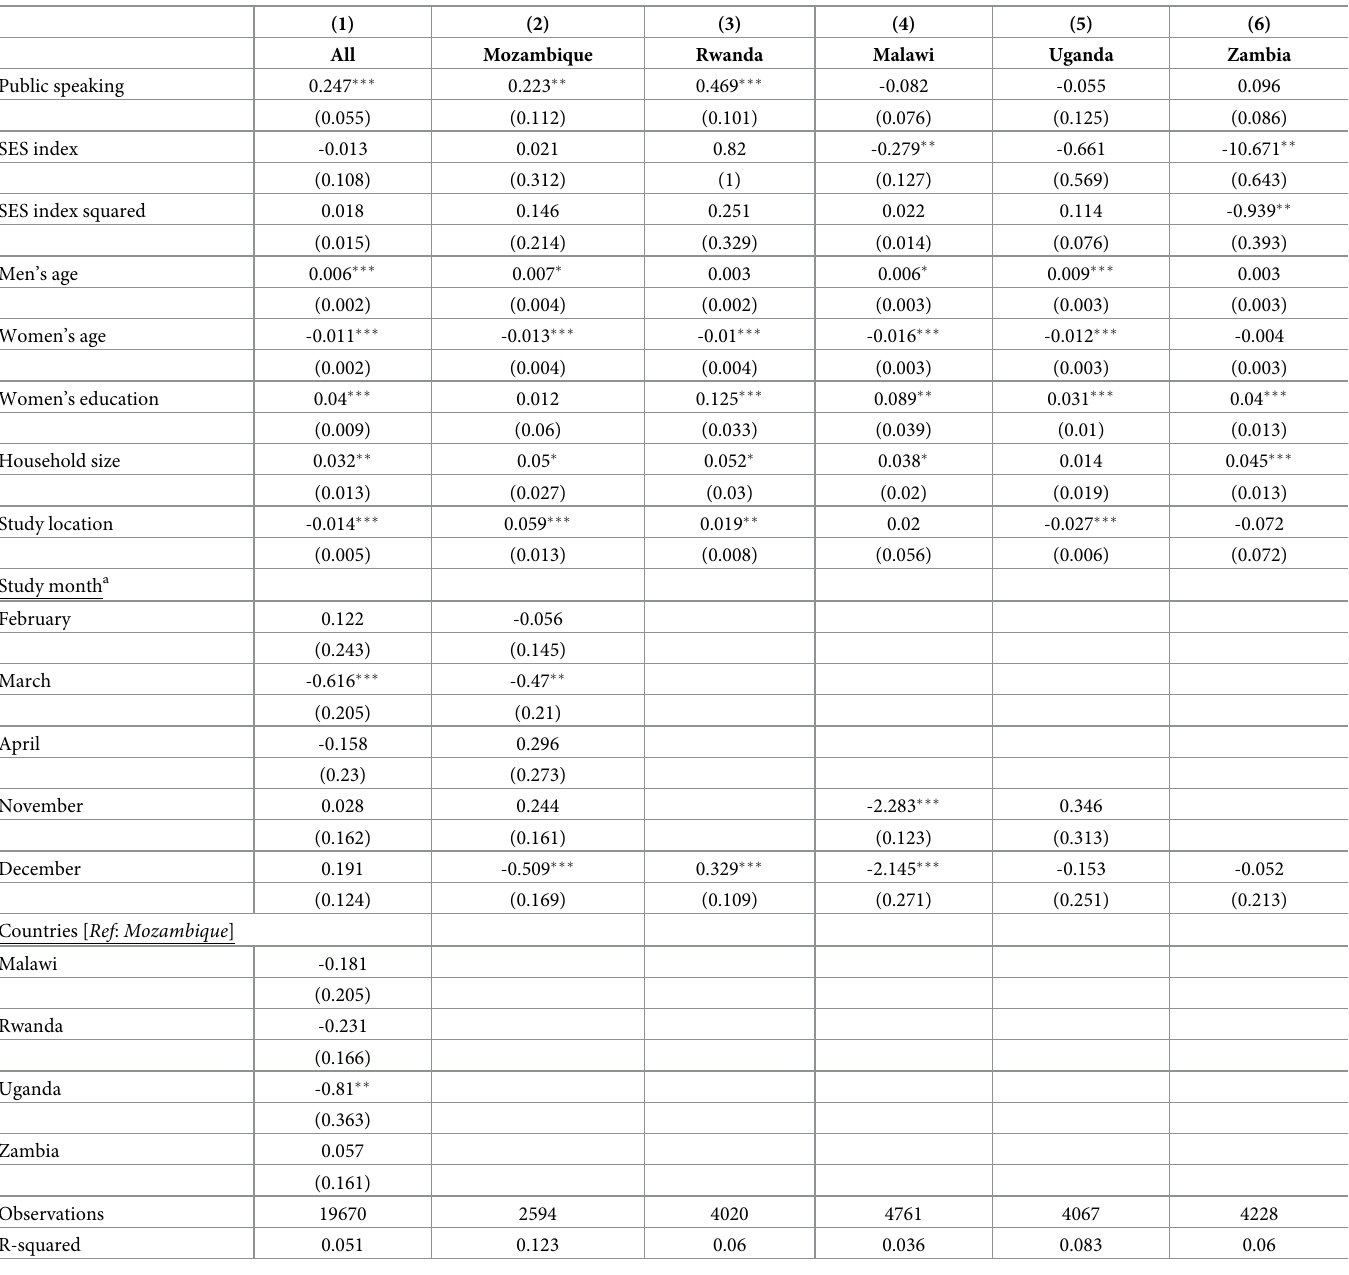
Table 12. OLS regression results for WDDS–leadership domain (comfortable speaking in public in � 1